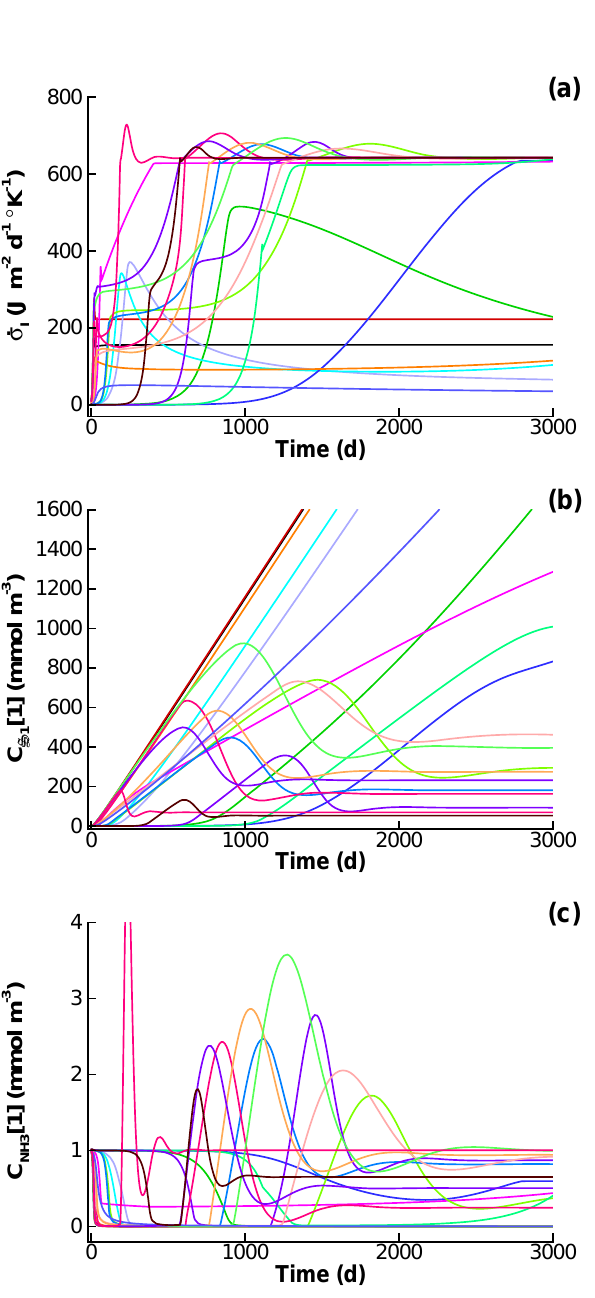
Fig. 6. Transient data for the top 20 entropy producing solutions from the 100,000 Monte Carlo simulations. (a) Total internal en- tropy production from both boxes [1] and [2] whoes steady state values range from 642.22 to 643.07Jm − 2 d − 1 ◦ K − 1 . (b) Con- centration of biological structure in box [1], C over the first 3000days of simulation. Values of ε i [ j ] for the above simulations are given in Table 3.